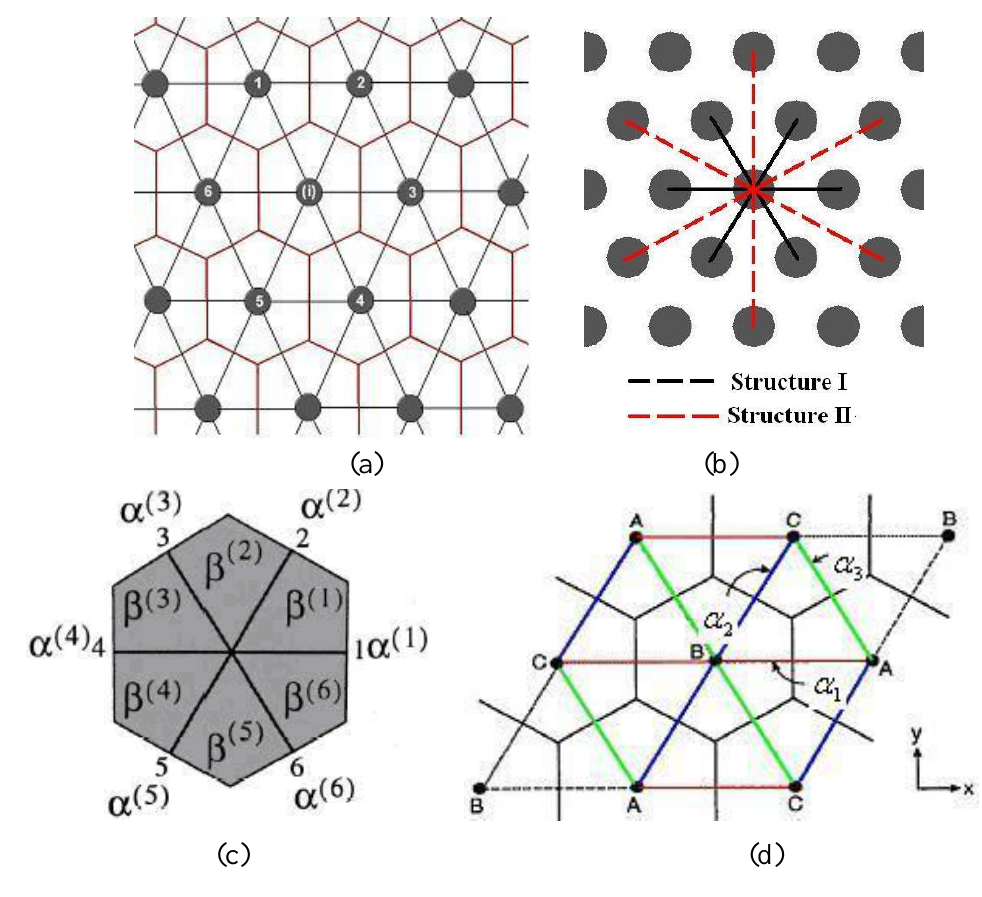
Figure 3. Interaction schemes in HLPM: (a) nearest neighboring axial interaction; (b) two-layer axial interaction (c) α-β model in equal-lateral triangular lattice structure; and (d) α-β-γ model in triangular lattice